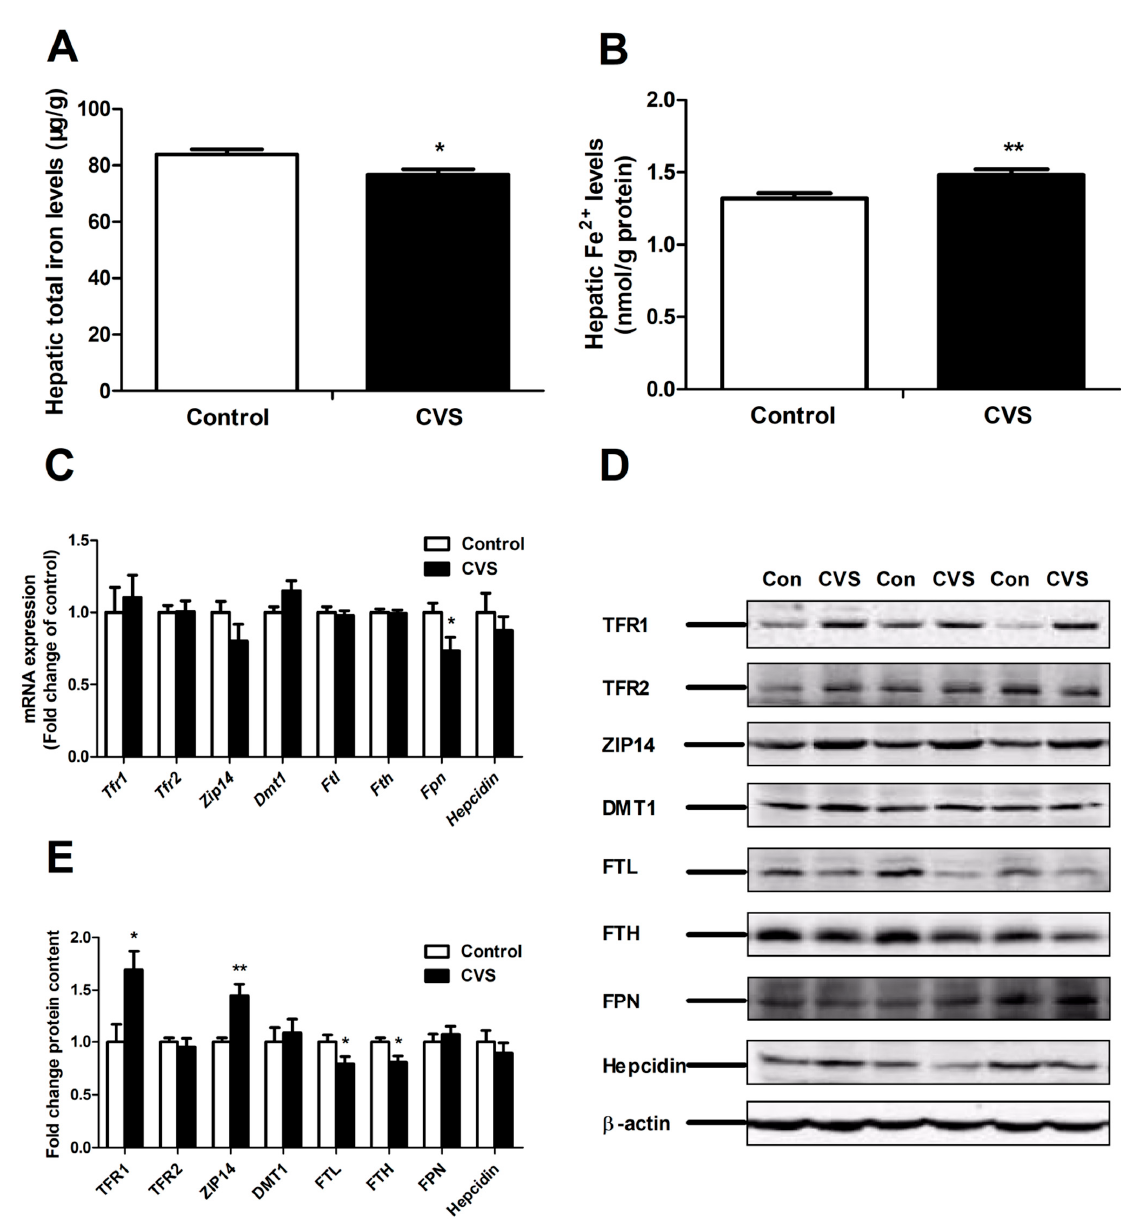
Figure 4. Effect of chronic variable stress on hepatic iron level and expression of iron metabolism-related genes and proteins. ( A ) Hepatic iron deposition. ( B ) Hepatic Fe 2+ level. ( C ) Expression of Tfr1 , Tfr2 , Zip14 , Dmt1 , Ftl , Fth, Fpn and Hepcidin mRNA were evaluated using qRT-PCR. ( D ) Representative Western blot analyses of TFR1, TFR2, ZIP14, DMT1, FTL, FTH, FPN and Hepcidin protein expression. ( E ) Densitometric analysis of Western blot results showing TFR1, TFR2, ZIP14, DMT1, FTH, FTL, FPN and Hepcidin protein levels. Con: control group; CVS: chronic variable stress group. Values were expressed as means ± SEM; n = 12 in each group for panels A,B; n = 7 in each group for panel C; n = 7 in each group for panel D. * p < 0.05, ** p < 0.01.